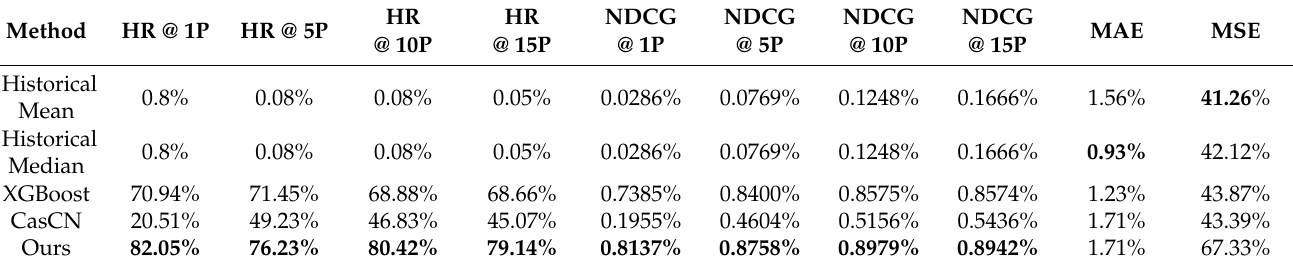
Table 4. The performance comparison for fake news popularity prediction.